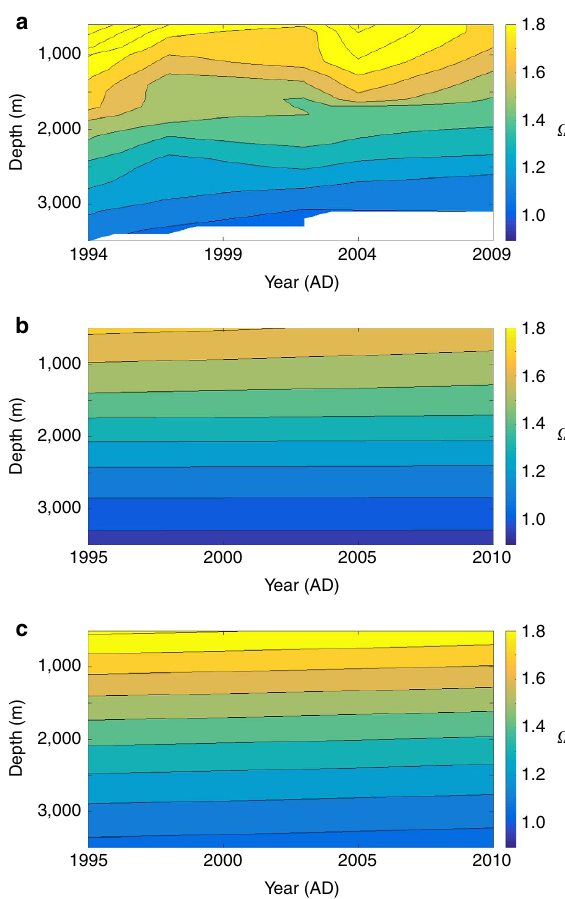
Figure 4 | Contour plots of aragonite saturation in the Arctic Ocean.